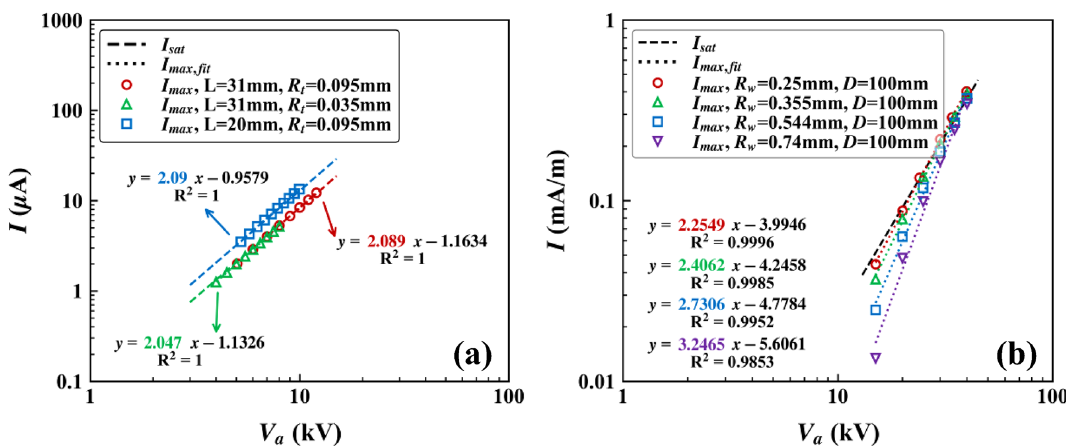
Figure 4. I sat and I max for a the pin-to-plane configuration under R i = 3 R t , and b the single wire-to-plane configurations under R i = 3 R w